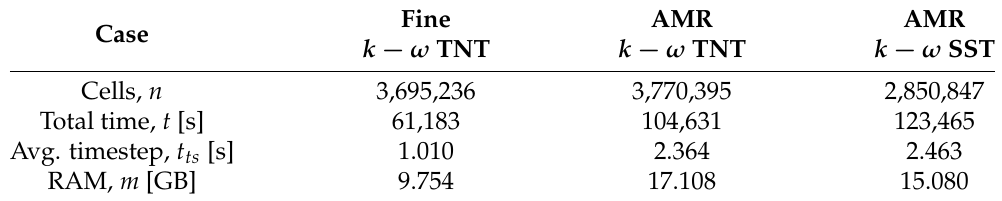
Table 2. Computational efficiency on fine grid and when using the AMR approach without load bal-